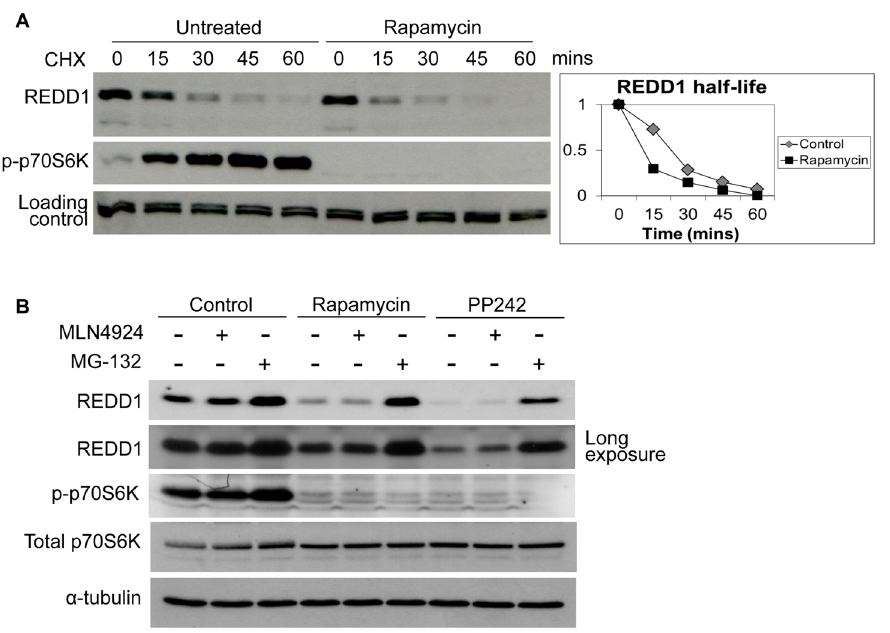
Figure 2. mTORC1 inhibition increases REDD1 degradation. ( A ) HEK293 cells were pretreated with 20 nM rapamycin for 1 hour followed by treatment with cycloheximide (40 m M) and cell lysis at the indicated time points. ( B ) Co-treatment of rapamycin (20 nM) or PP242 (2 m M) with MLN4924 (2 m M) or MG-132 (20 m M) were performed in HEK293 cells as indicated for 4 hours followed by cell lysis. measured the protein half-life using cycloheximide chase with two different HUWE1 siRNAs. However, in both experiments there was no significant change in the half-life of REDD1 in cells with HUWE1 knockdown compared to controls (Figures 3 C and D).